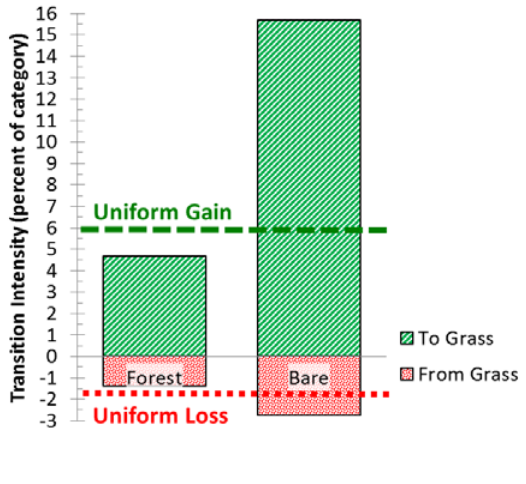
Figure 7. Intensity of transitions given Grass’ gain on the positive axis and given Grass’ loss on the negative axis.